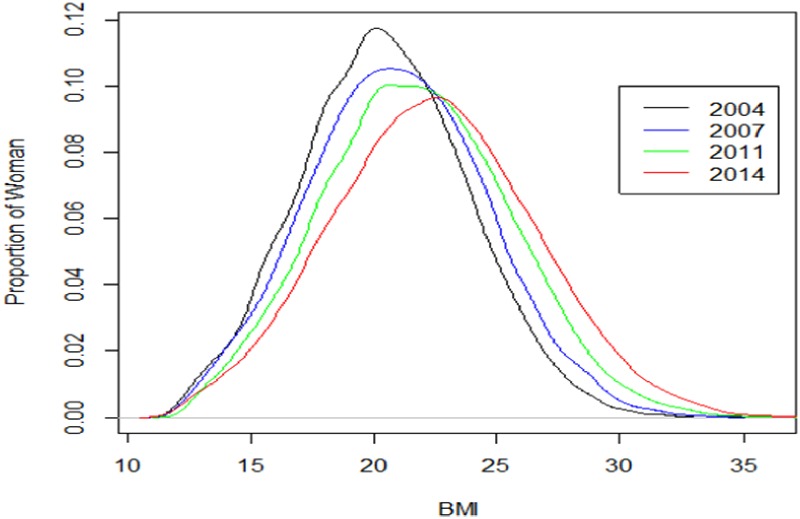
BMI distribution of women from 2004 to 2014 (mean and SD).